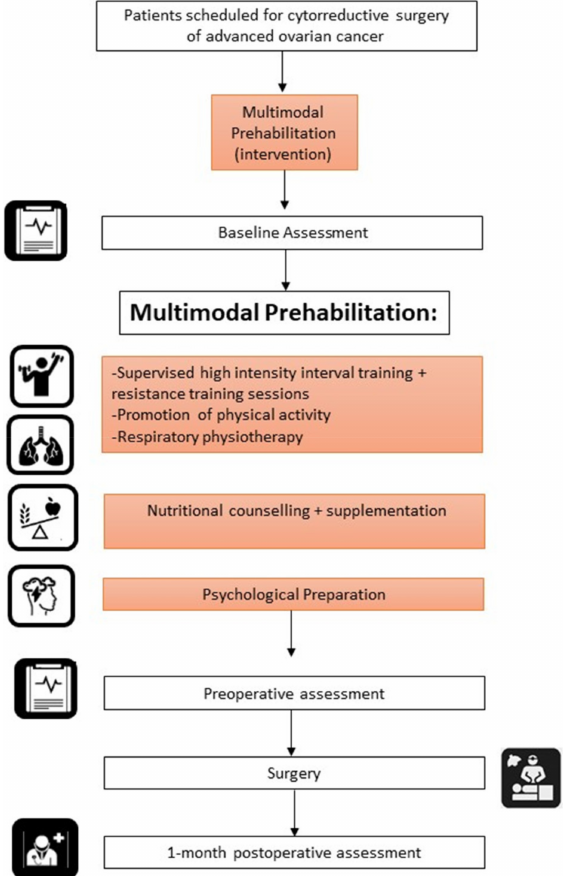
Figure 1. Flow diagram showing the timing of patient assessments and interventions in the prehabili- tation